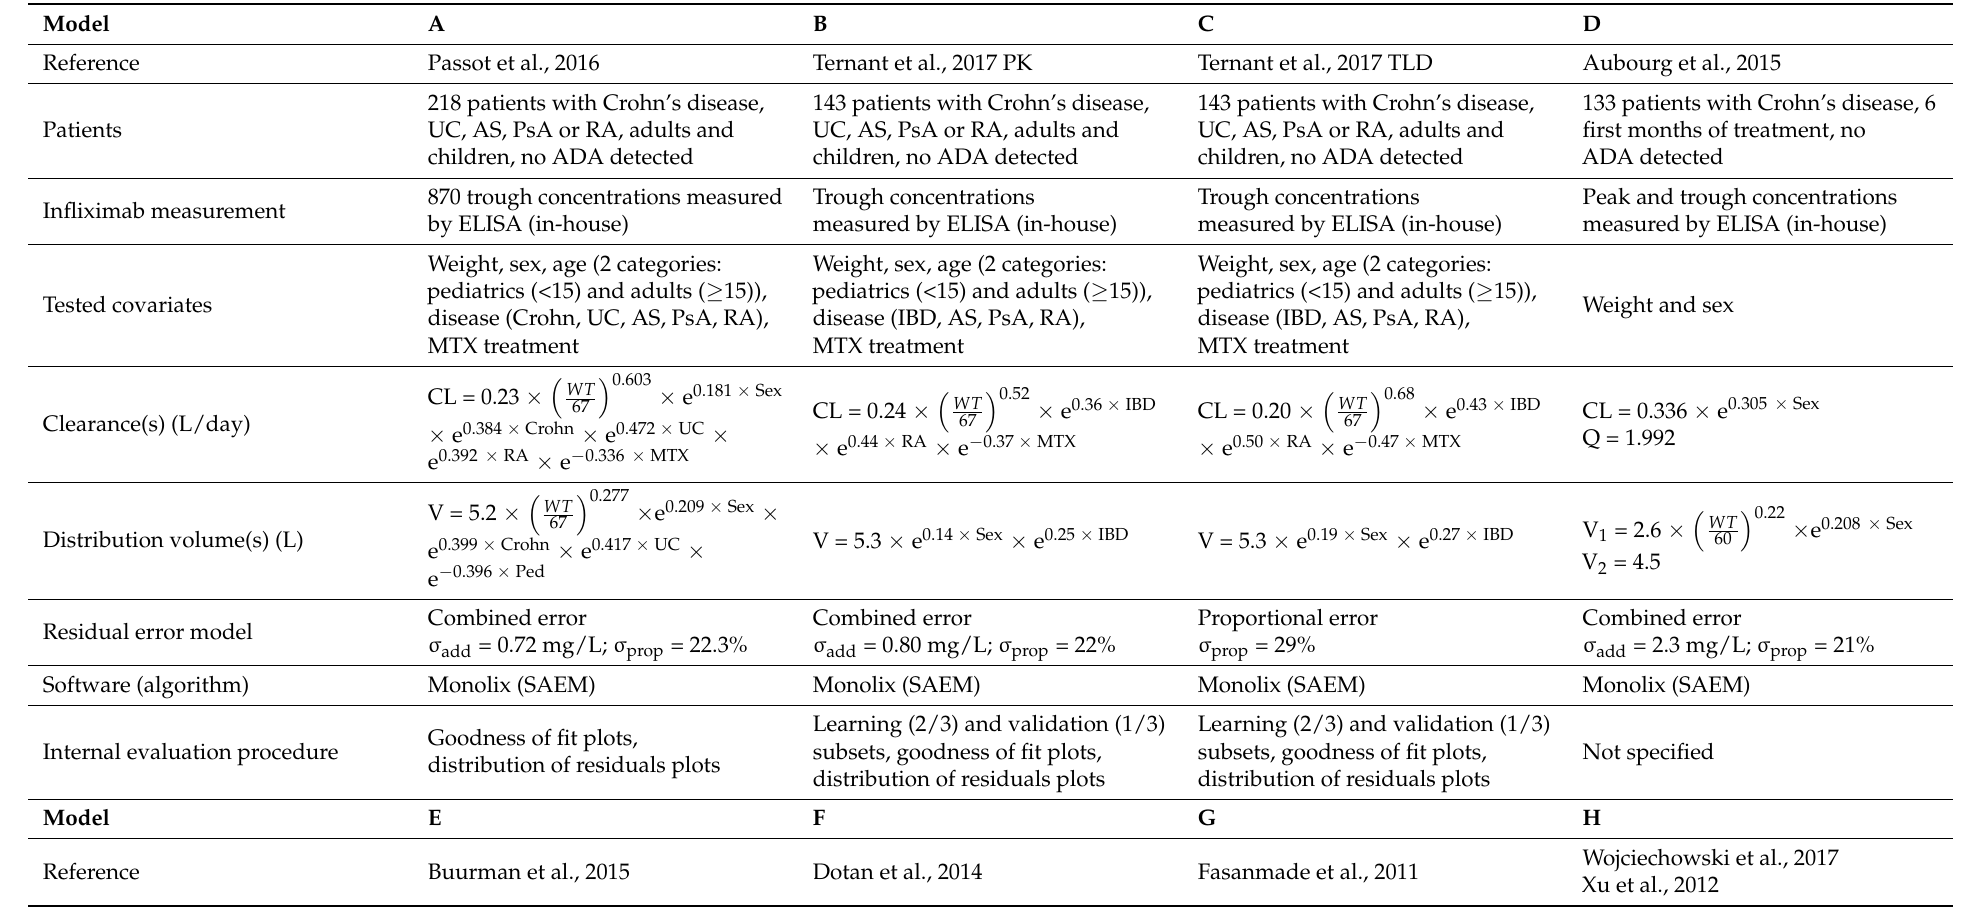
Table 1. Summary of the 8 models selected for the external